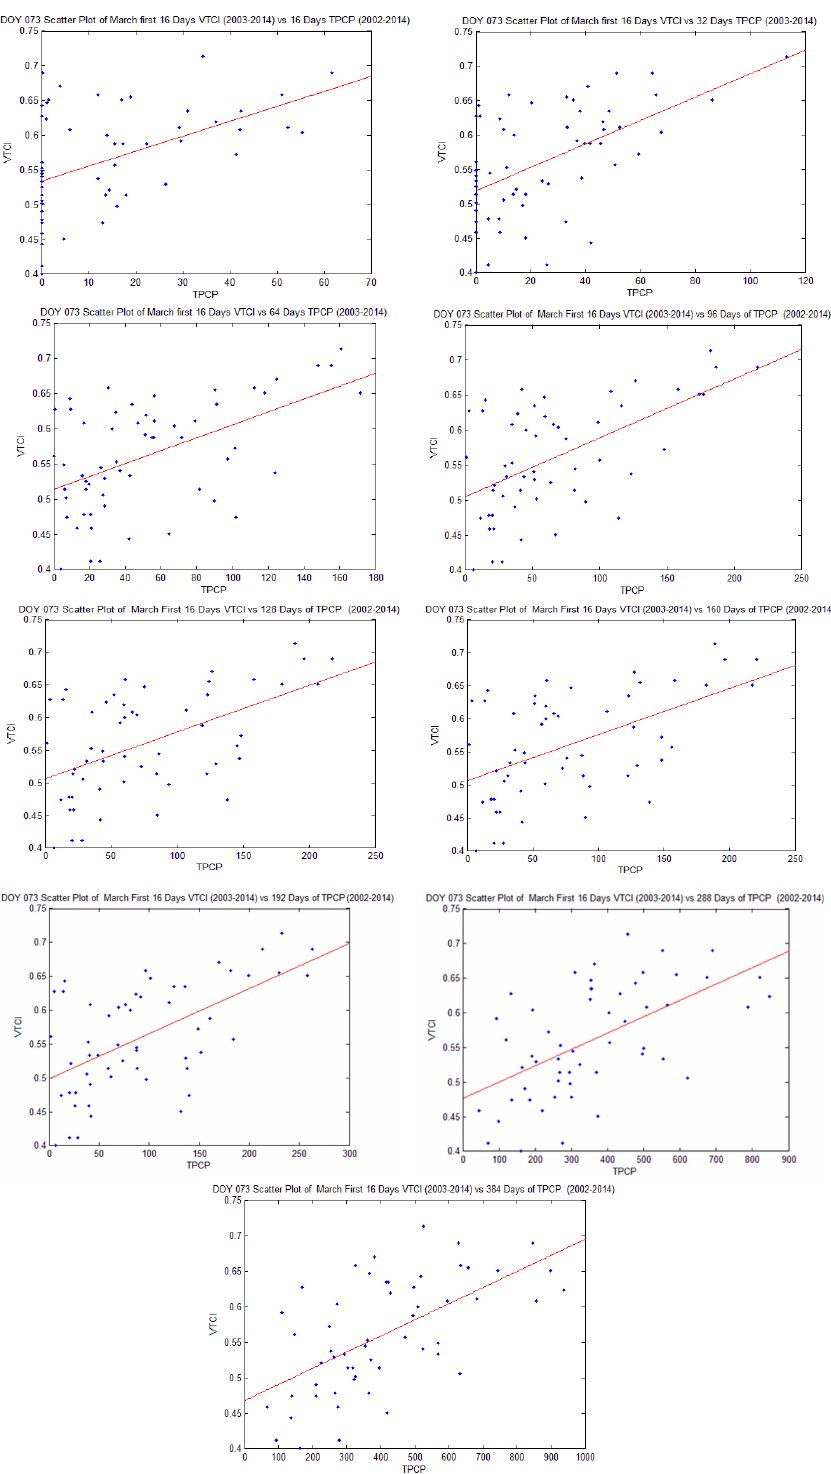
Figure 10. Linear Correlation of VTCI (D ‐ 073) and TPCP (D ‐ 016 to D ‐ 384) plots at five different meteorological stations for sixteen days to one ‐ year, spanning over 2003–2014 for VTCI, and 2002– 2014 for TPCP, in the given periods.